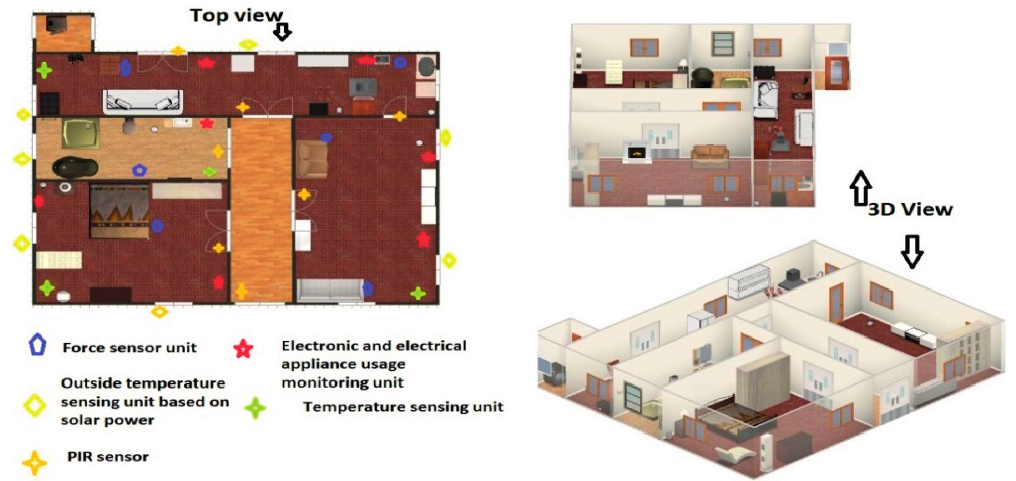
Figure 2. Layout structure of the house with sensor deployment and household